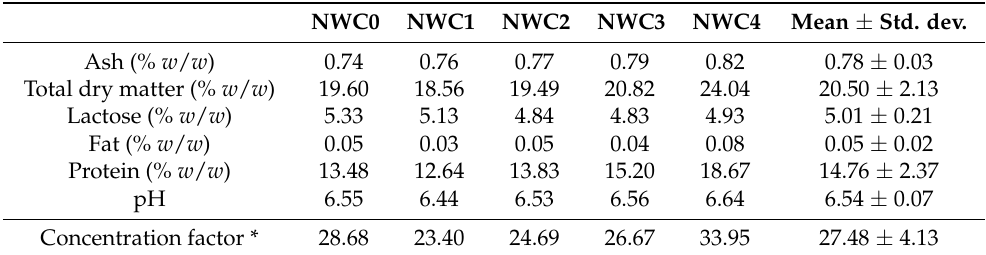
Table 1. Composition of the five native whey concentrate (NWC) batches before treatment. Std. dev. = standard